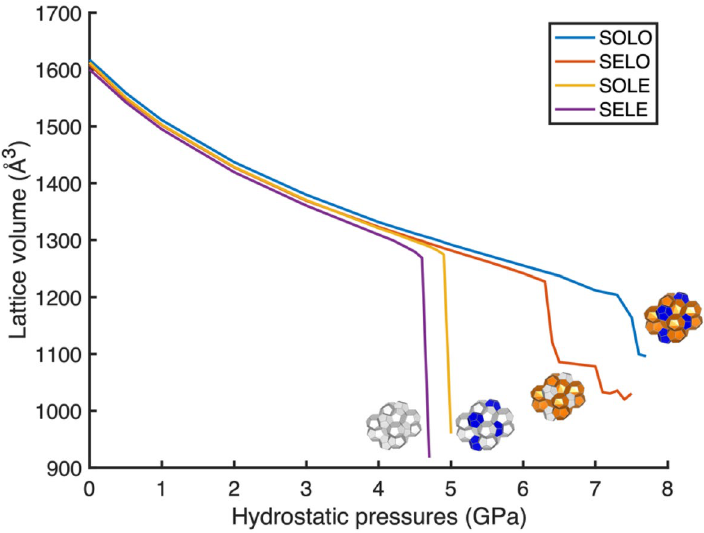
Figure 2. Lattice volume as a function of hydrostatic pressures from 0 to 7.6 GPa with four different occupancies. The blue line is for the SOLO hydrate. The orange line is for the SELO hydrate. The yellow and purple are for the SOLE and SELE hydrates. See text for